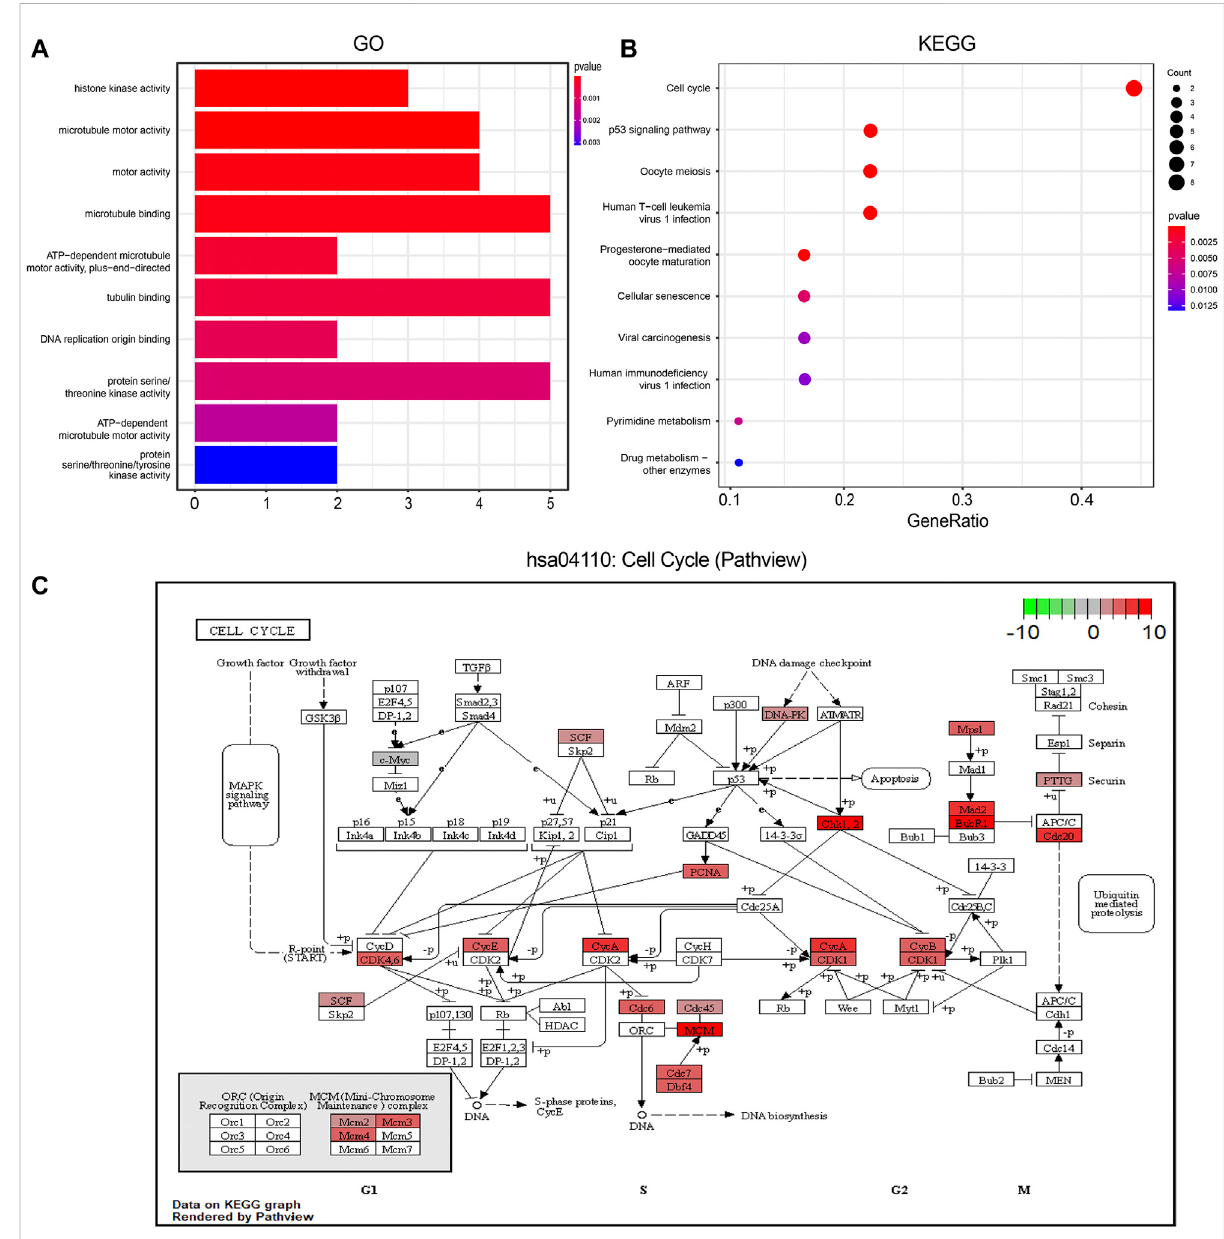
FIGURE 5 Function enrichment analysis of Hub genes. (A) . GO enrichment analysis. The color of the columns indicates the corrected p value; longer column indicates higher number of enriched genes; (B) . KEGG enrichment analysis; the annotation is the same as before; (C) . The most signi fi